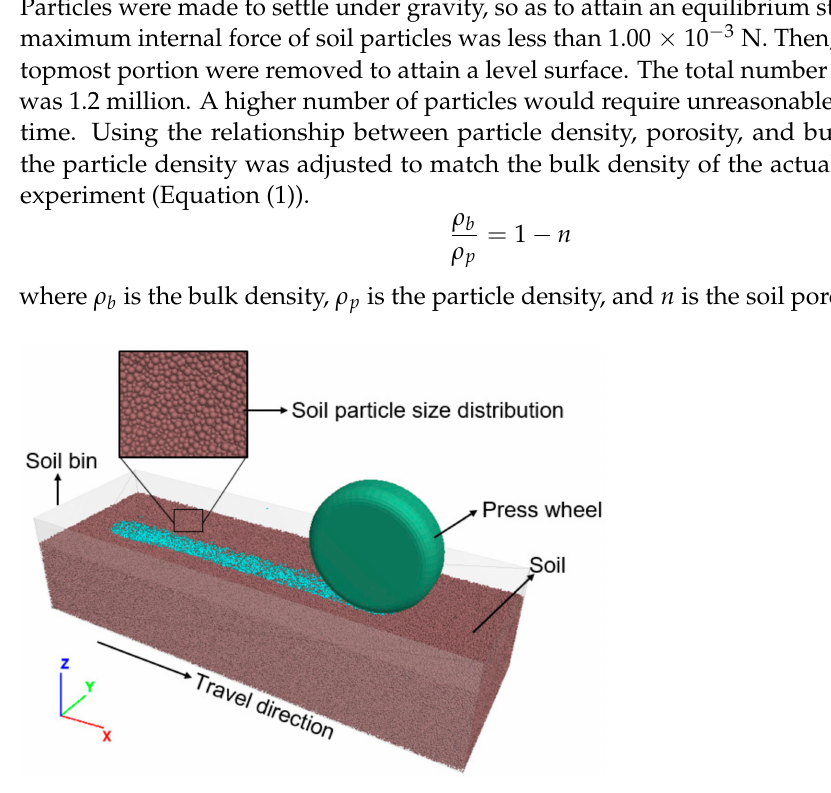
Figure 2. Soil–wheel model indicating travel